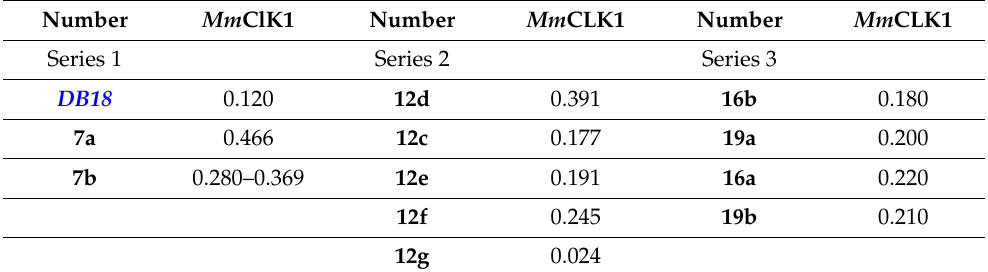
Table 5. IC 50 data ( µ M) for the inhibition of Mm CLK1 by selectednew quinazolines.